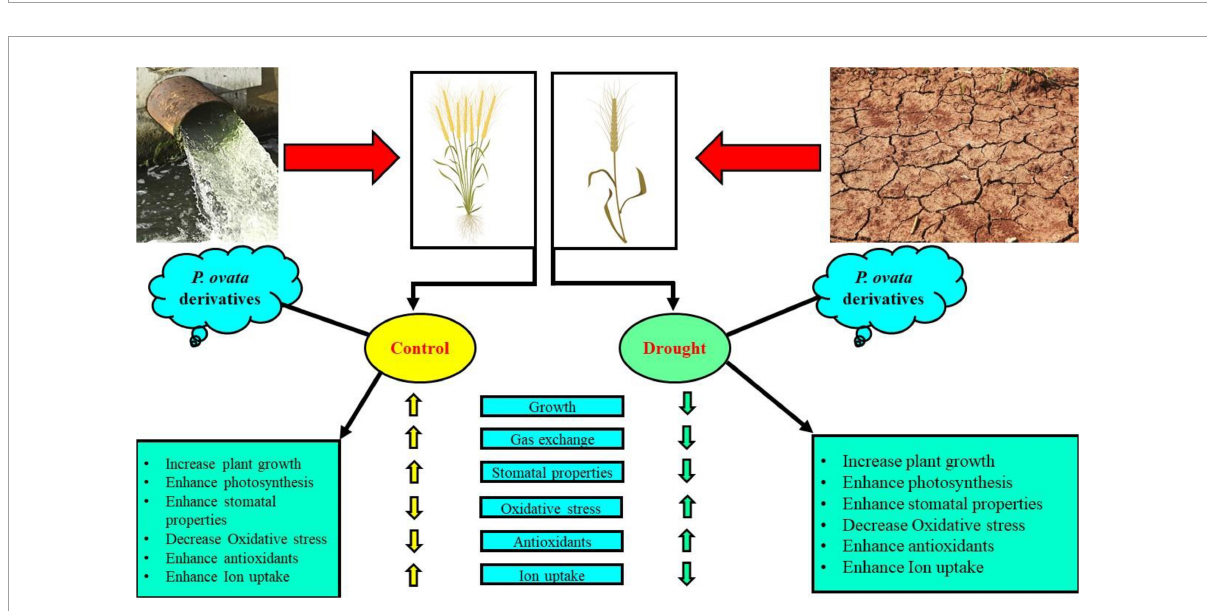
FIGURE11 Schematic presentation interpreting the mechanistic role of Plantago ovata Forsk leaf extract (POLE) in alleviating the drought stress in wheat. The drought stress inhibited plant growth characteristics and higher ROS concentration was accumulated in the roots and shoots of wheat. In contrast, the application of POLE significantly alleviated the negative impact of drought stress and improved root and shoot growth and alleviated ROS accumulation. POLE addition regulated the antioxidant defense system while reduced the oxidative stress and relative membrane permeability. The current study demonstrated that POLE could relieve drought stress in wheat by reducing oxidative stress at the root surface, and regulating proficient antioxidant coordination in the roots and shoots of